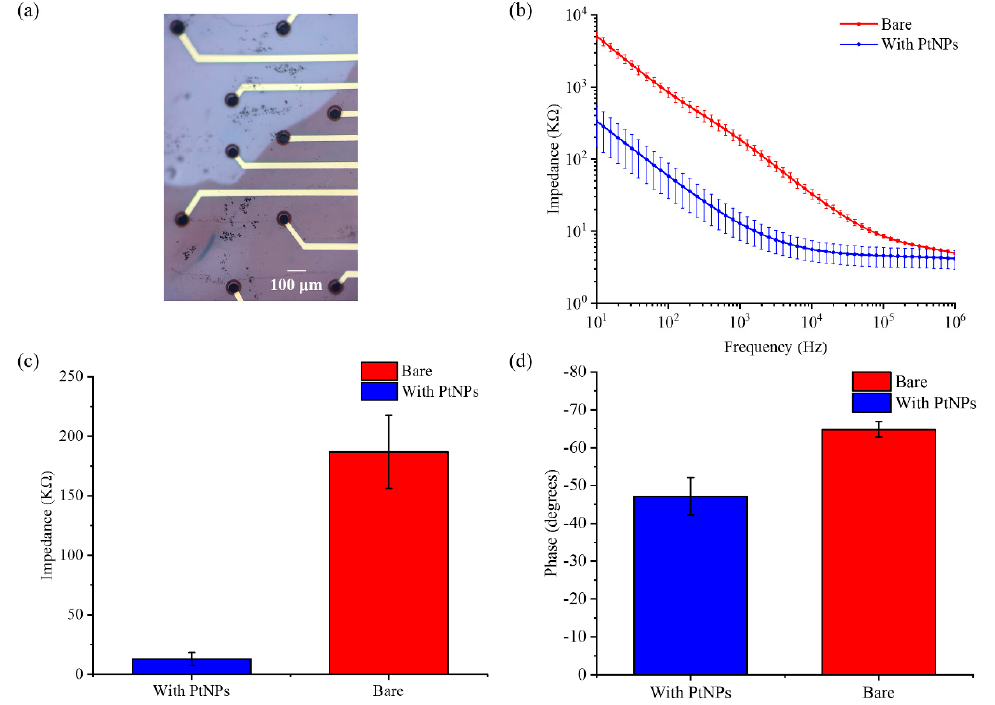
Figure 4. The flexible ECoG electrode array was modified with platinum black nanoparticles (PtNPs). ( a ) Photomicrograph of the electrode array with PtNPs modification; ( b ) Electrode impedance plots before and after PtNPs modification; ( c ) At 1 kHz frequency, the impedance decreased from 186.96 ± 30.62 k Ω to 12.78 ± 5.35 k Ω ; ( d ) The phase increased from − 64.79 ± 2.01° to − 47.17 ± 4.96°.